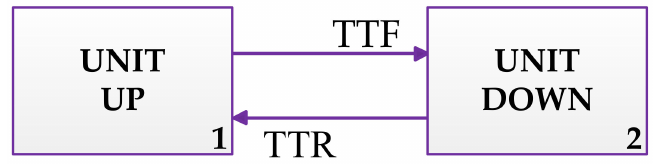
Figure 3. Two-state model for a base load